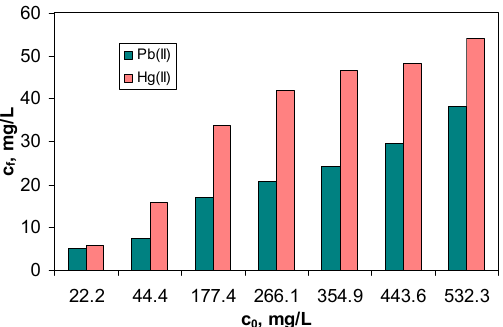
Figure 3. Dependence between the final concentration and the initial concentration of metal ions in the case of Pb(II) and Hg(II) ions biosorption onto RWB.